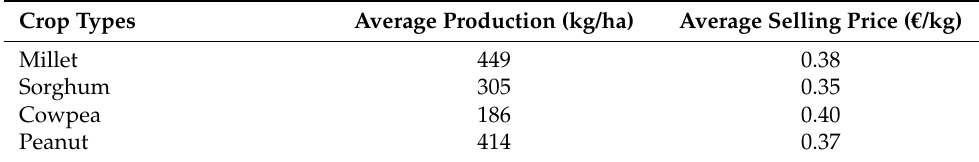
Table 3. Production quantity and selling price of main crops in the suburbs of Niamey